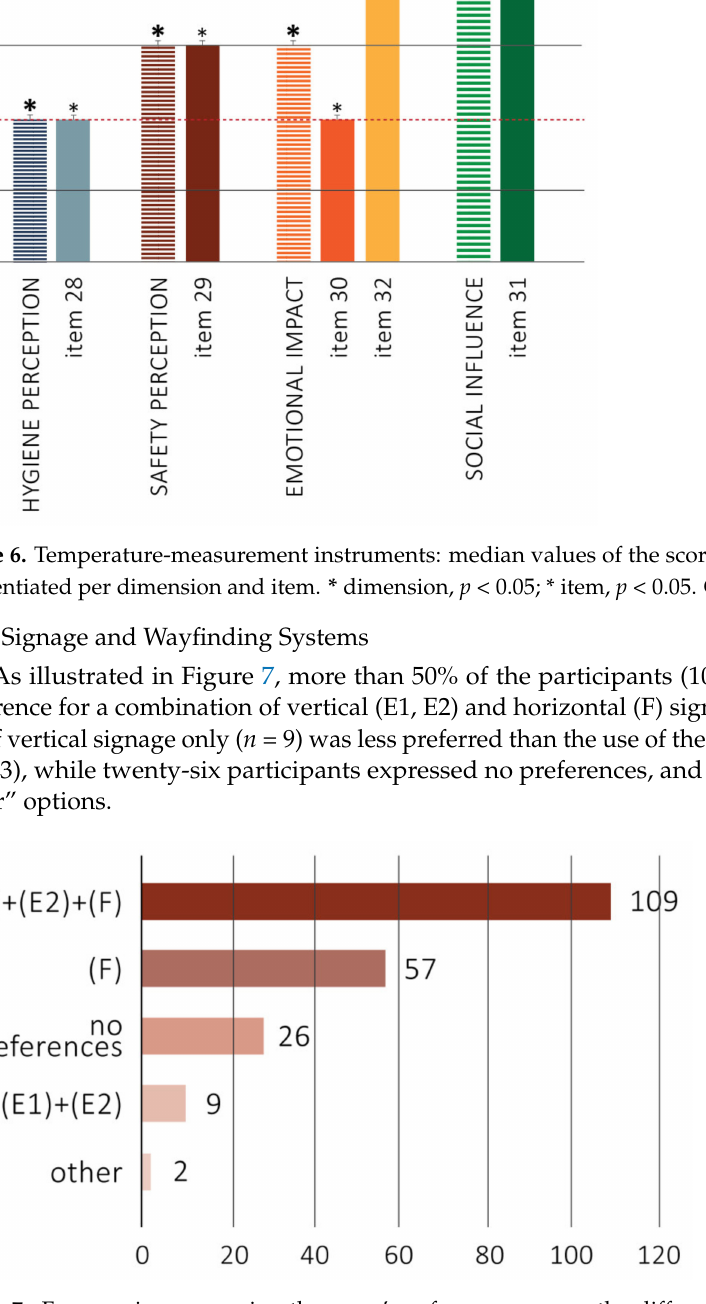
Figure 7. Frequencies concerning the users’ preferences among the different implementation of wayfinding systems (E1, E2 F). Own